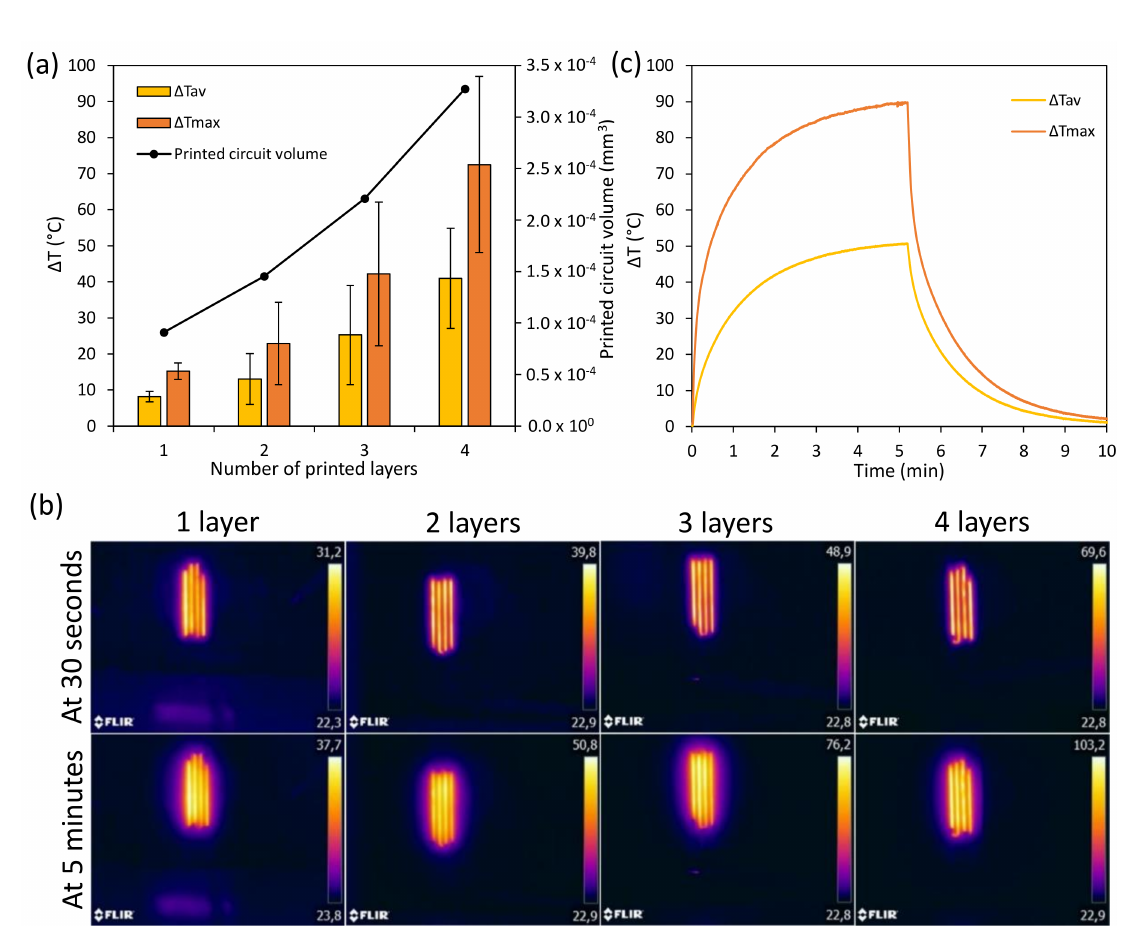
Figure 7. Self-heating tests by Joule’s heating. ( a ) Average and maximum temperature increment with respect to room temperature (left axis), and printed circuit volume (right axis) as a function of the number of printed layers, ( b ) IR images at different heating times during self-heating tests as a function of the number of printed layers and ( c ) self-heating test of a 4-layer circuit showing average and maximum temperature increments of the circuit as a function of